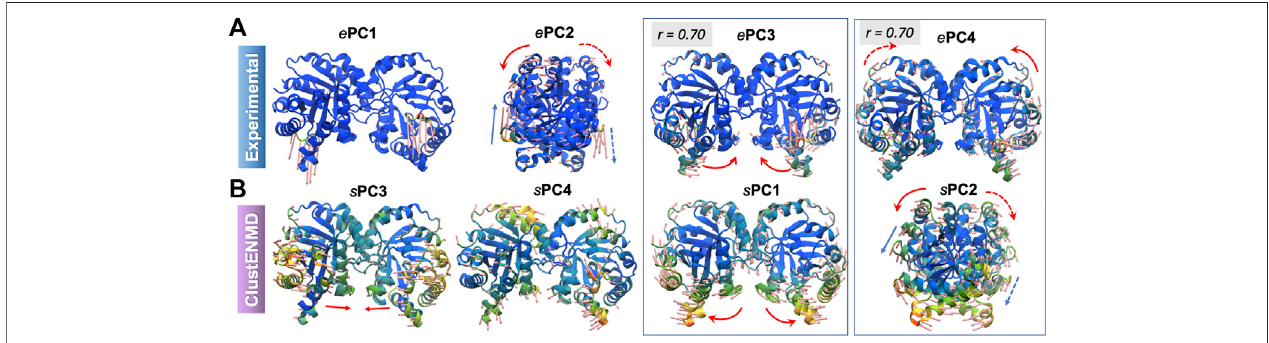
FIGURE 5 | First four principal modes for TIM ensembles. The (A,B) refer to experimental and ClustENMD ensembles, respectively. Those PCs that exhibit high ( > 0.70) correlations are enclosed in boxes. See the corresponding movies in Supplementary Movie S2